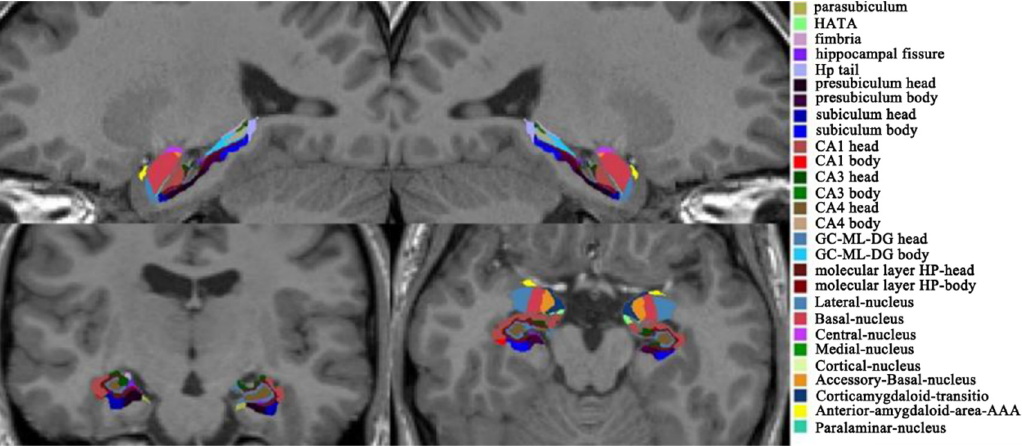
Figure 2. Subfields of the amygdala and hippocampus. CA, cornuammonis; HATA, hippocampal amygdala transition area; GC_ML_DG: granule cell layers of the dentate gyrus.